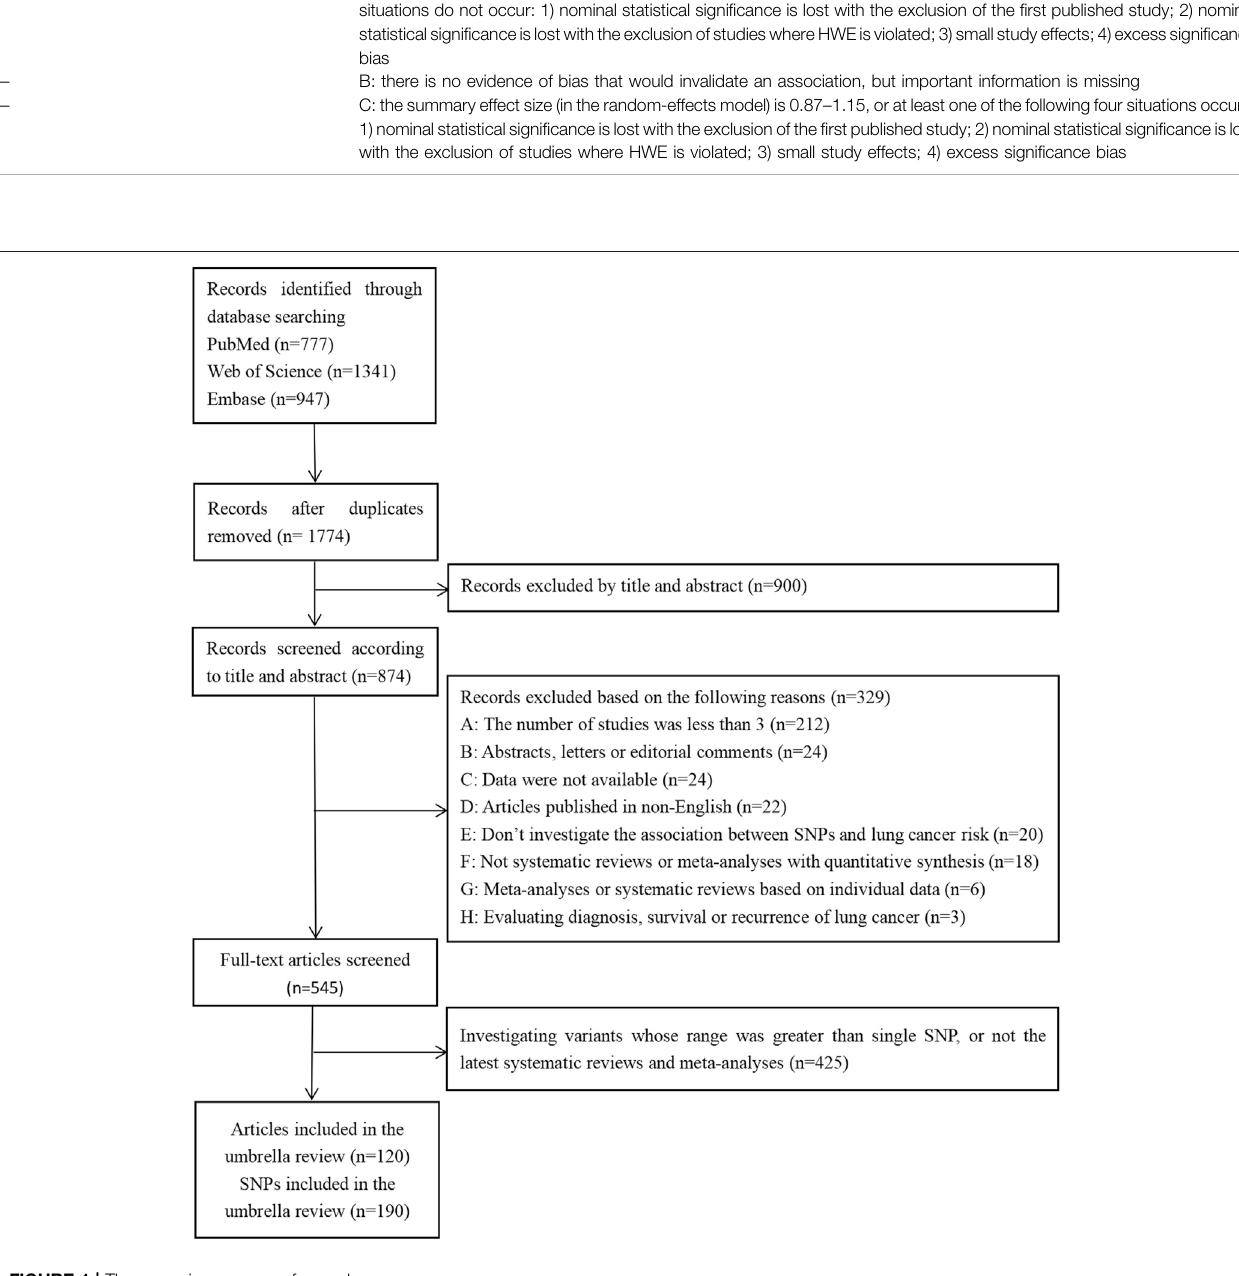
FIGURE 1 | The screening process of